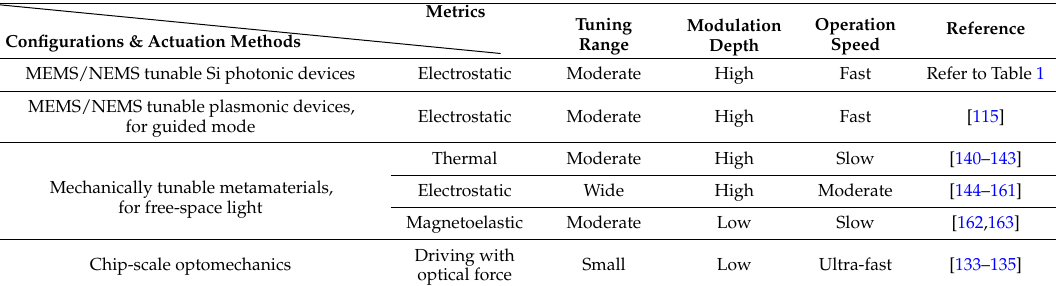
Table 2. Comparison of light modulation performances with MEMS/NEMS tunable Si photonic devices, plasmonic devices, mechanically tunable metamaterials, and chip-scale optomechanic devices.